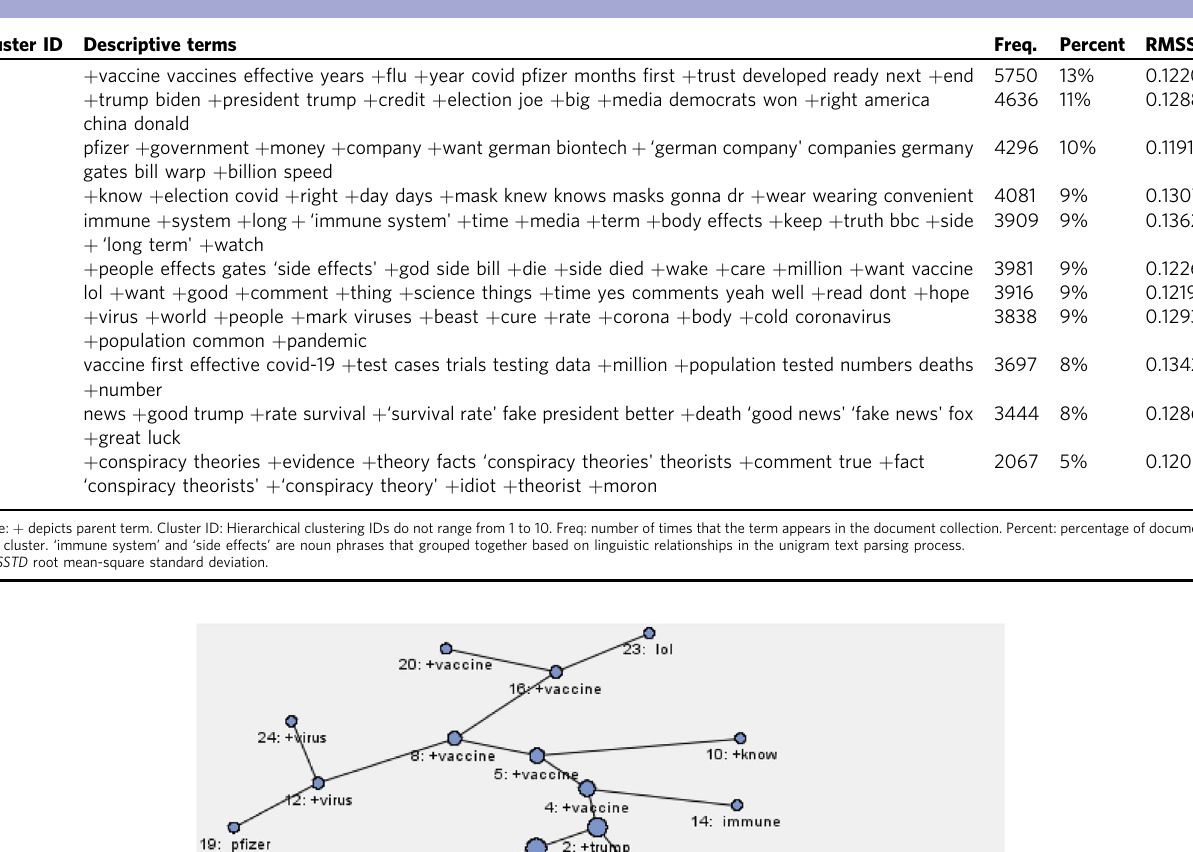
Table 3 Text cluster results.